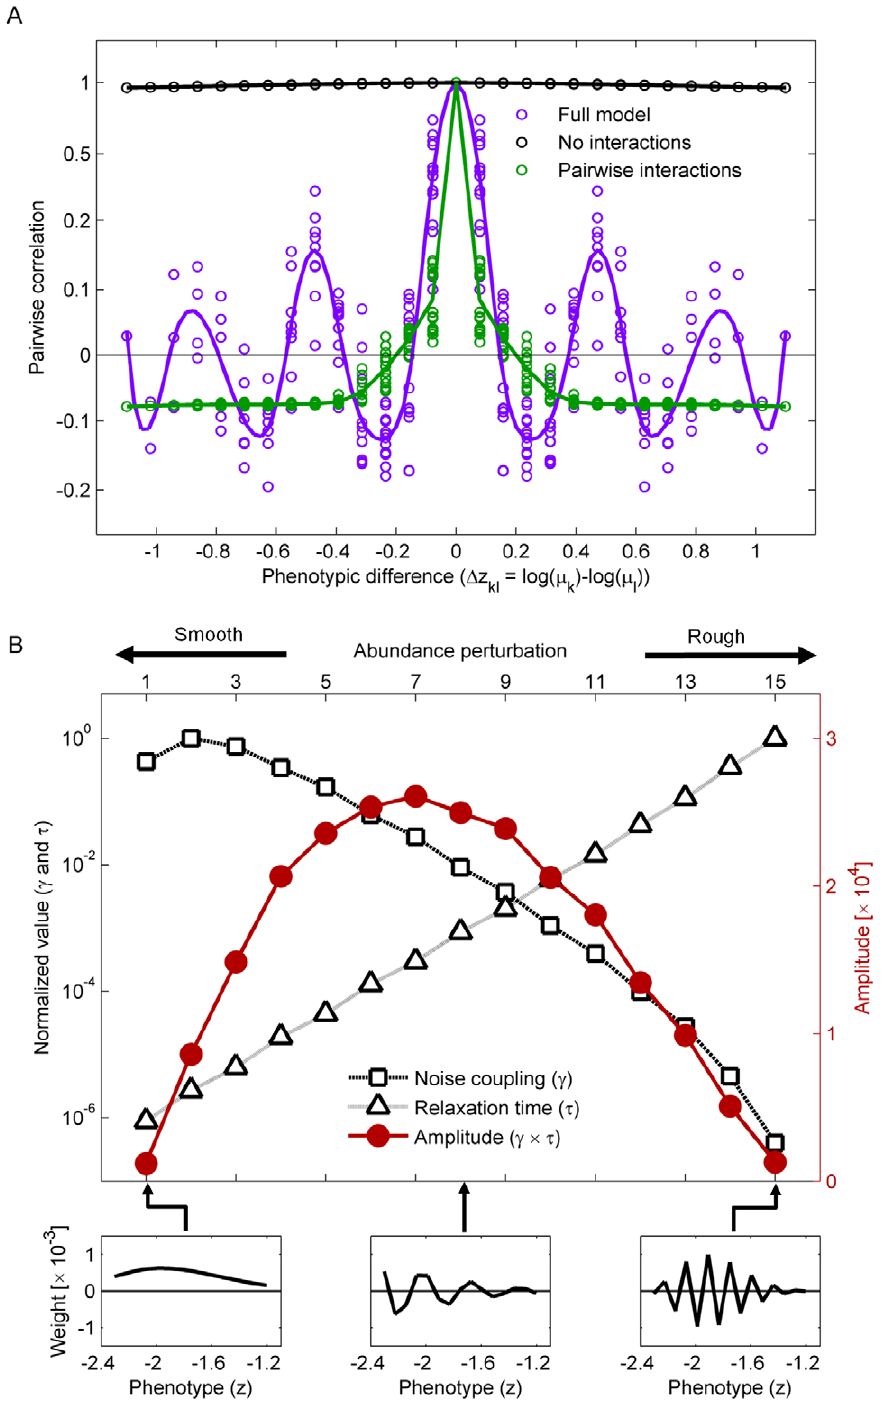
Figure 4. Alternating patterns of species correlation and clustering results from a balance between noise and many-species interactions. (A) Pair-wise correlations of species as a function of their phenotypic difference. Shown are the correlations in the full model (purple), and when only one species (No interactions, black) or two species (Pair-wise interactions, green) are allowed to fluctuate, all for the exact same noise- series in the dispersal dilution factor a (coefficient of variation 0.15). Dashed lines are splines through the mean values to guide the eye; the y -axis has been stretched near 0 to make details clearer. Without interaction, the individually fluctuating species show almost 100% correlations (Moran effect). Pair-wise interactions give rise to negative correlations between sufficiently different species (compensatory dynamics). However, only when all species are interacting do we see alternating correlations, indicating species clustering in phenotype space. Correlations are calculated from a data- series of 10 5 steps. Since some timescales in the model are longer than simulations can feasibly be run, the correlations calculated depend on the length of the simulated run; however, here we are interested only in the contrast between the three patterns for a fixed simulation time. (B) Stability (Relaxation time, t ; triangles) and tendency to be generated by noise (Noise-coupling, c ; squares) for the 15 basic abundance perturbations around the steady state (eigenvectors of the linearized interactions, see Methods). The 15 perturbations are arranged by roughness, as illustrated by the three